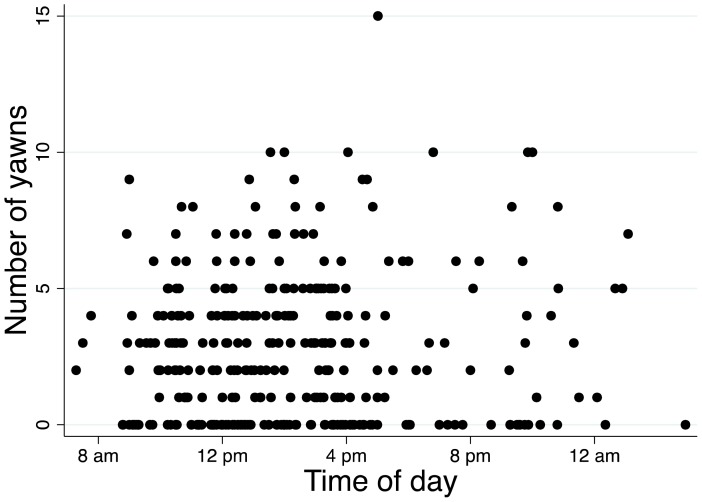
Yawns produced throughout the day.Times after 12:00am were considered to be very late evening. With this definition, the earliest time observed was 7:17am, and the latest was 2:56am.